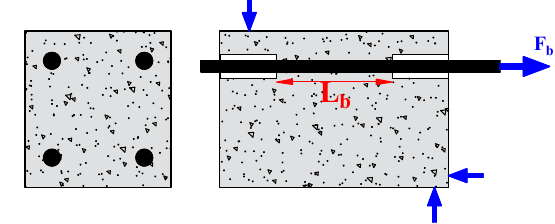
Figure 9. Beam test: ( a ) with a pocket; ( b ) with a hinge.